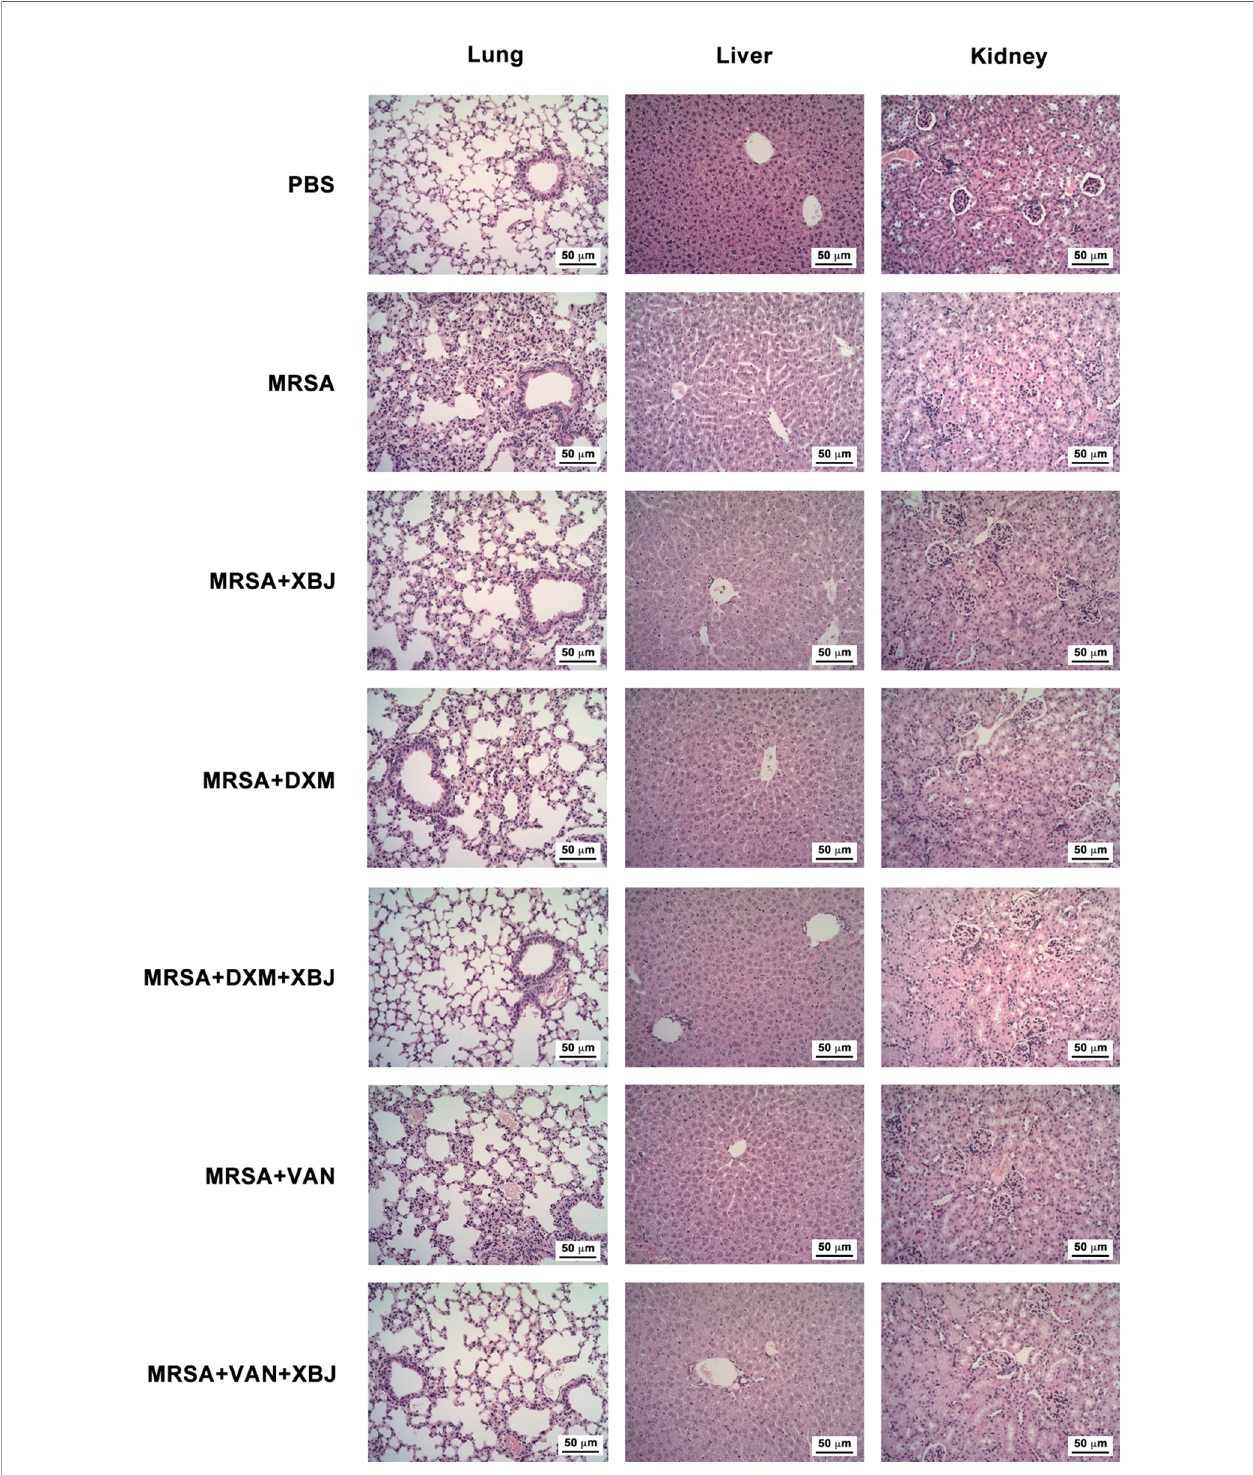
FIGURE 4 | XBJ relieved organ damage caused by MRSA infection. C57BL/6J female mice were randomly divided into seven groups and intraperitoneally injected with MRSA (4 × 10 8 CFU/mouse) and XBJ (5 ml/kg), DXM (7 mg/kg), VAN (110 mg/kg), and their combination in corresponding groups. H&E-staining (200×) of tissue sections from lungs, livers, and kidneys were carried out from the indicated groups (N =